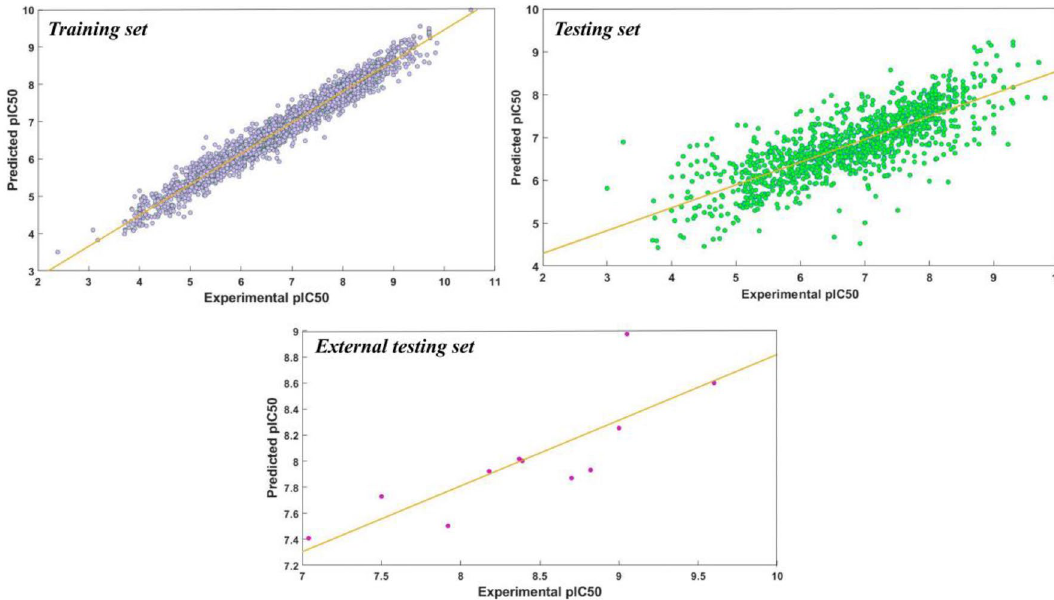
Figure 6. Experimental versus predicted pIC50 for training, testing, and external testing set. The orange line represents the data trendline. The figure is created by using WEKA 3.8.4 open-source